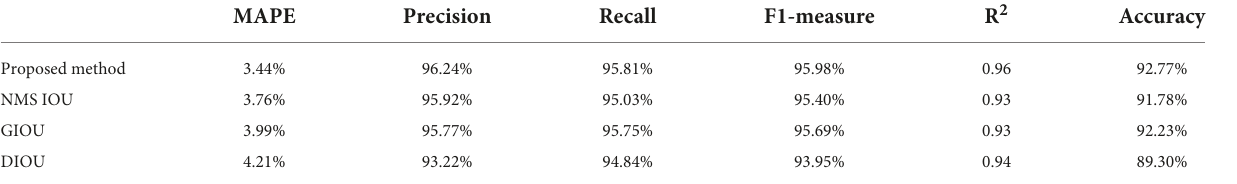
TABLE 2 Evaluation of detection results of different methods. MAPE Precision Recall F1-measure R 2